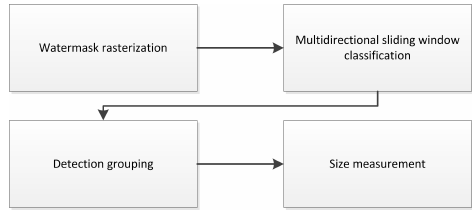
Figure 1: The detection process 2.1 The classifier